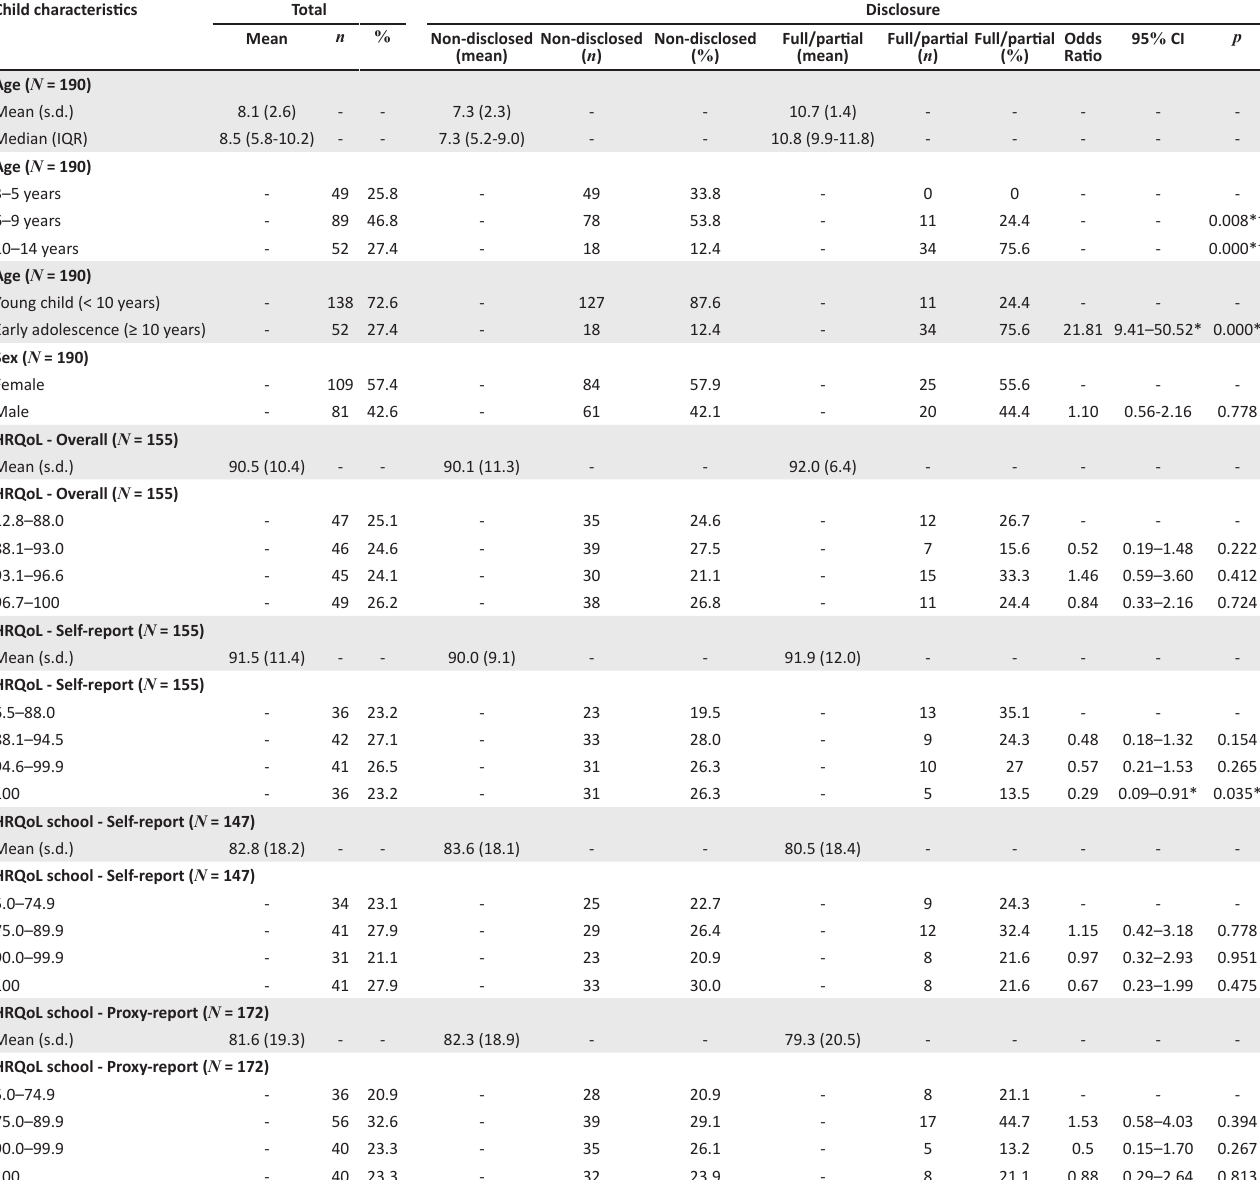
TABLE 1: Associations between disclosure and child characteristics – Univariate analyses. Child characteristics